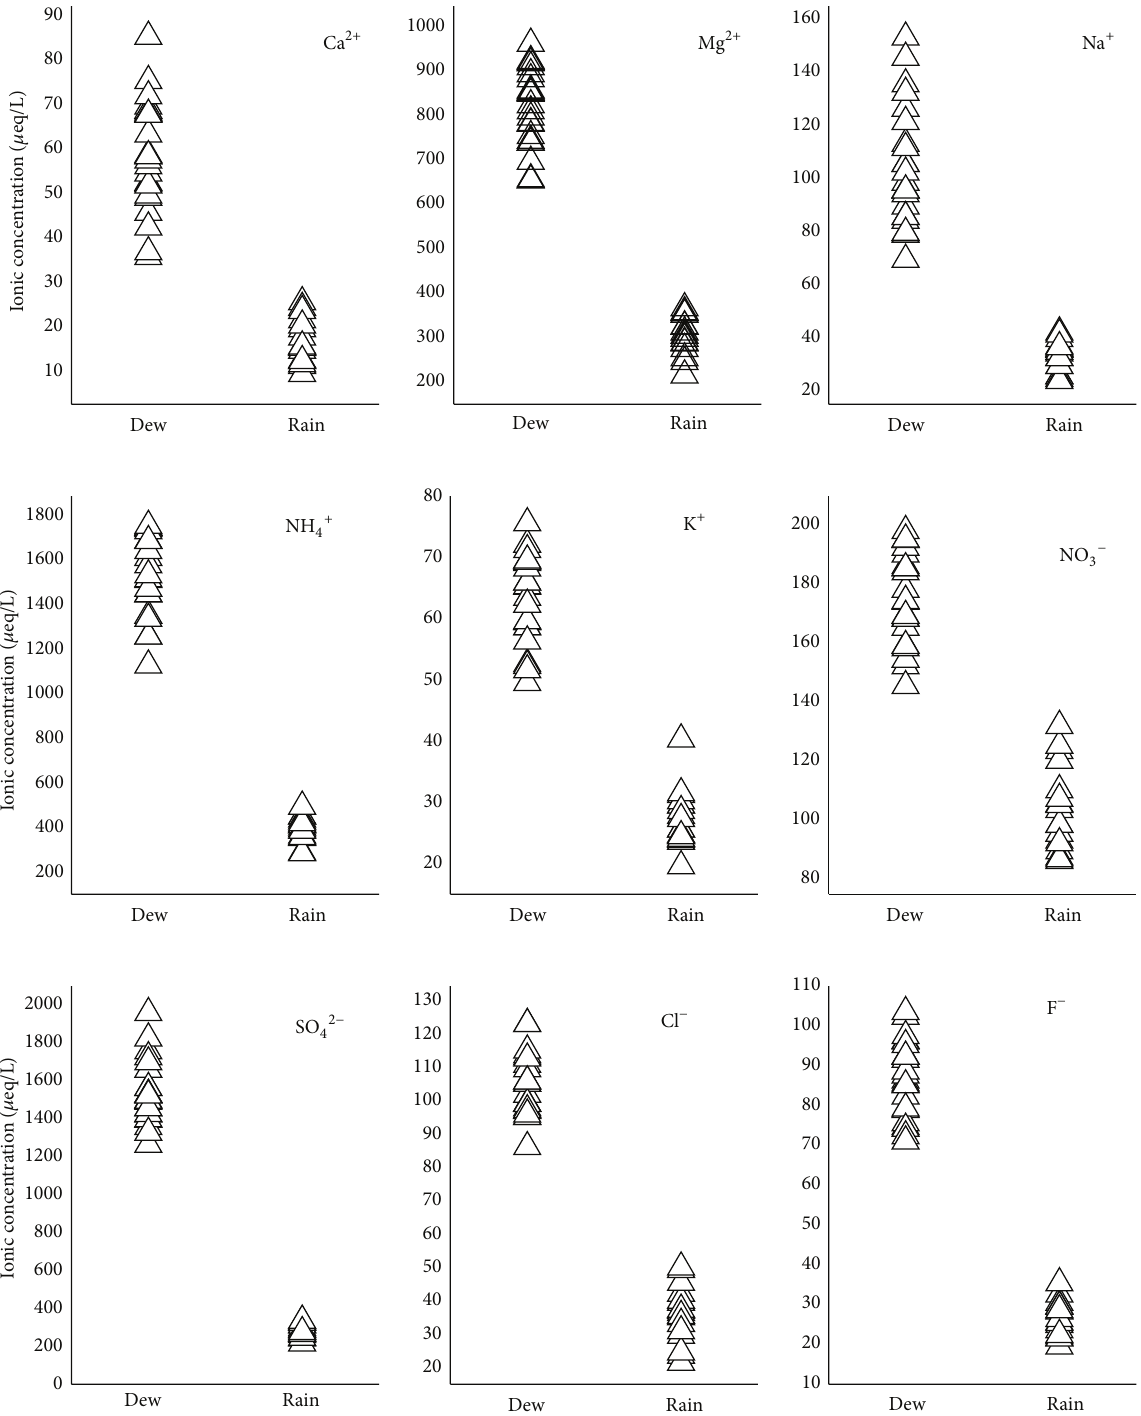
rain event happened on 6 August and on 20 July. The reason for the higher ionic concentration of dew is the longer period without rain. This shows that the dust that acts as the nuclei of dew is decreased by rain and that ion concentrations in dew also declined after the precipitation